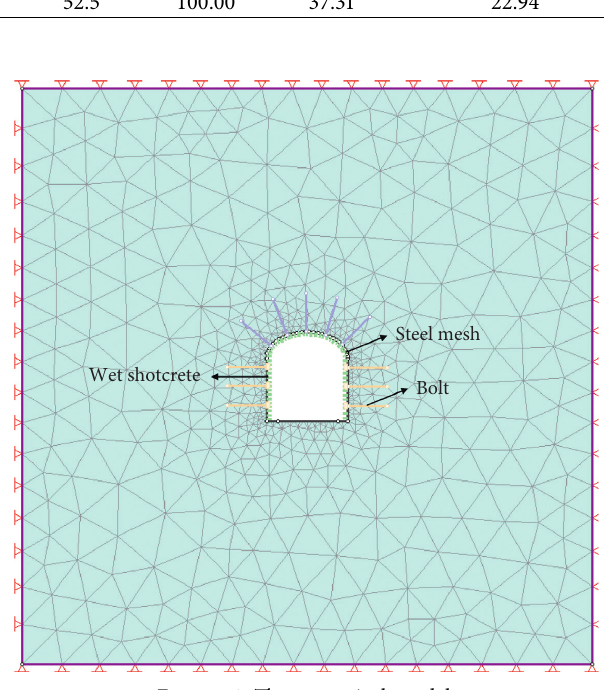
Figure 4: The numerical